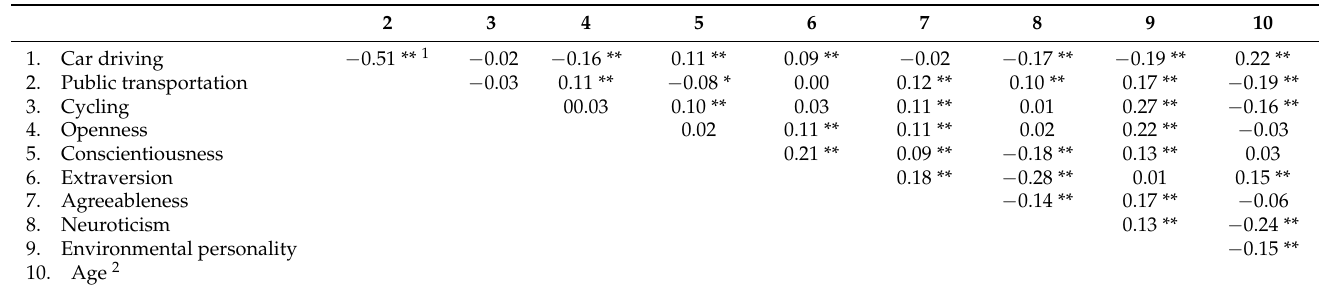
Table 2. Pearson correlation matrix for transportation modes, personality traits, and